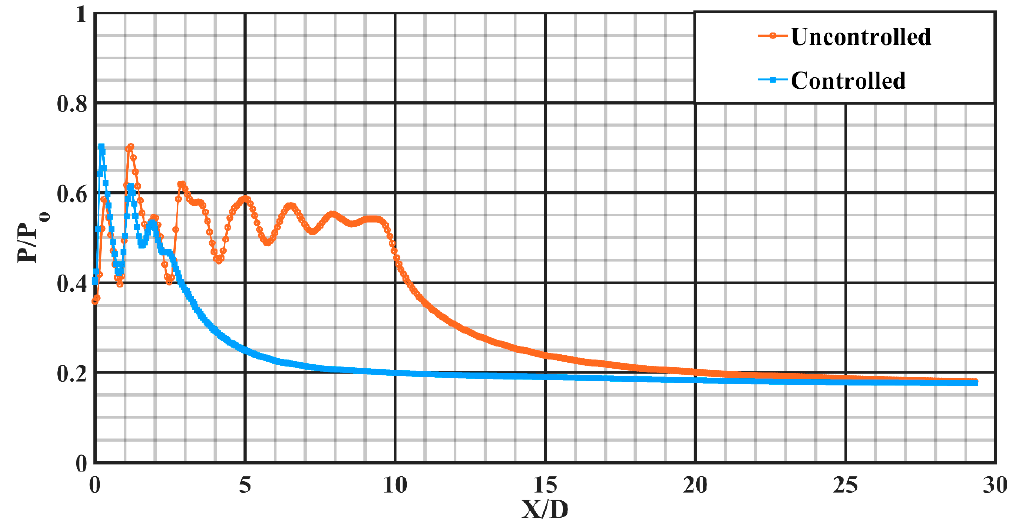
Figure 13. Decay of Jet centerline pressure for Mach 1.8 at NPR 6.